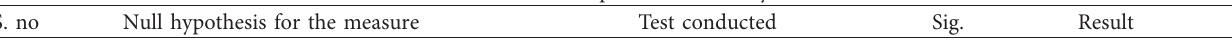
Table 9: Students’ performance analysis.